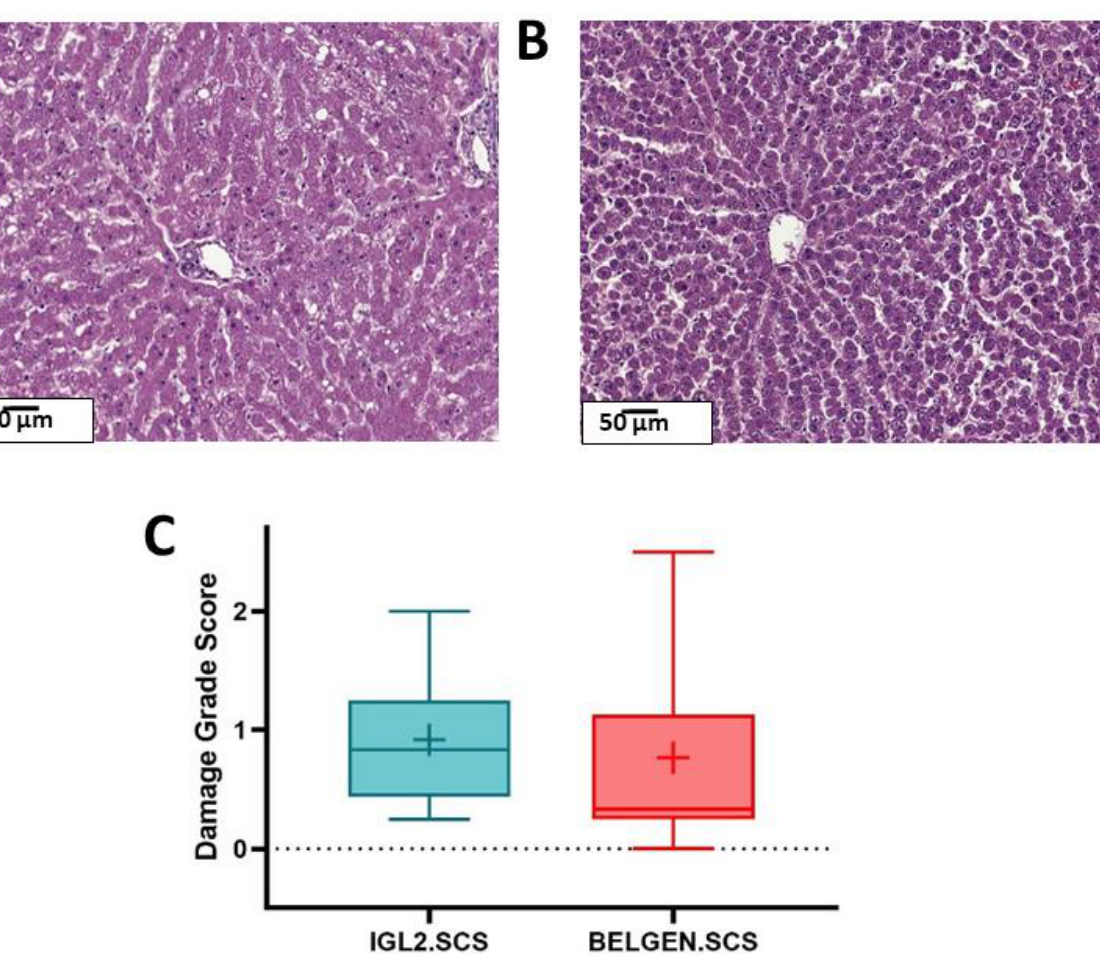
Figure 1. Liver histology after 24 h SCS + 2 h NMP. ( A ) IGL2.SCS ( B ) BELGEN.SCS ( C ) The damage grade score (DGS) was assessed by an expert pathologist and tended to be higher in the IGL2.SCS Group ( p = 0.68) (Kruskal–Wallis